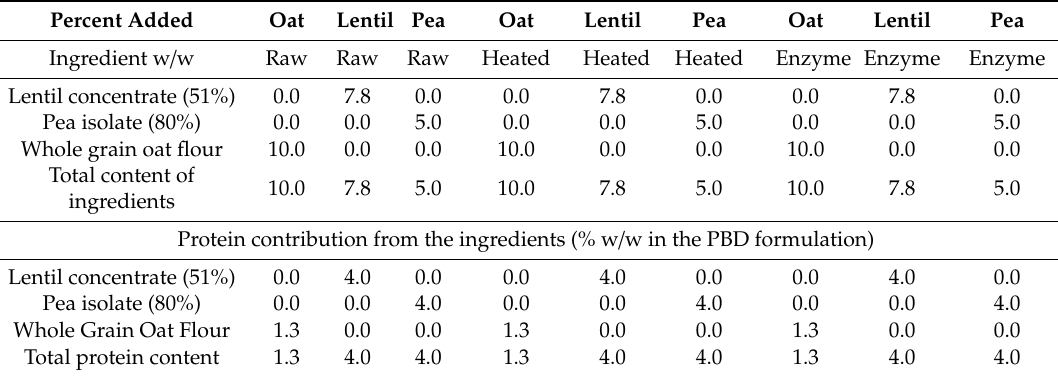
Table 2. Added ingredients and their protein contribution to the single ingredient